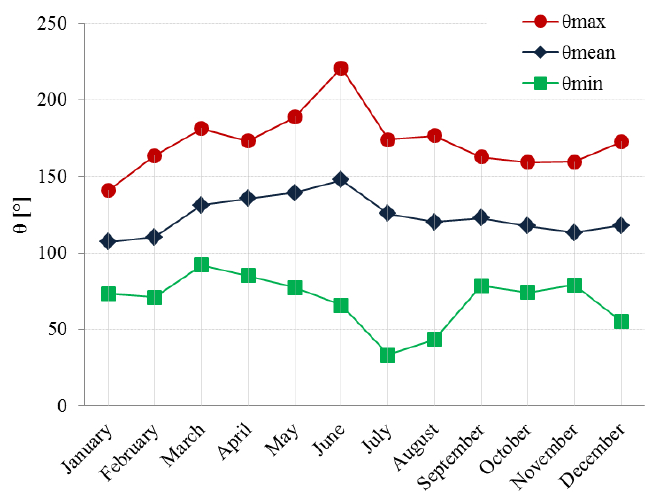
Figure 9. Monthly distribution of the wave direction, averaged over 10 years at point P16.